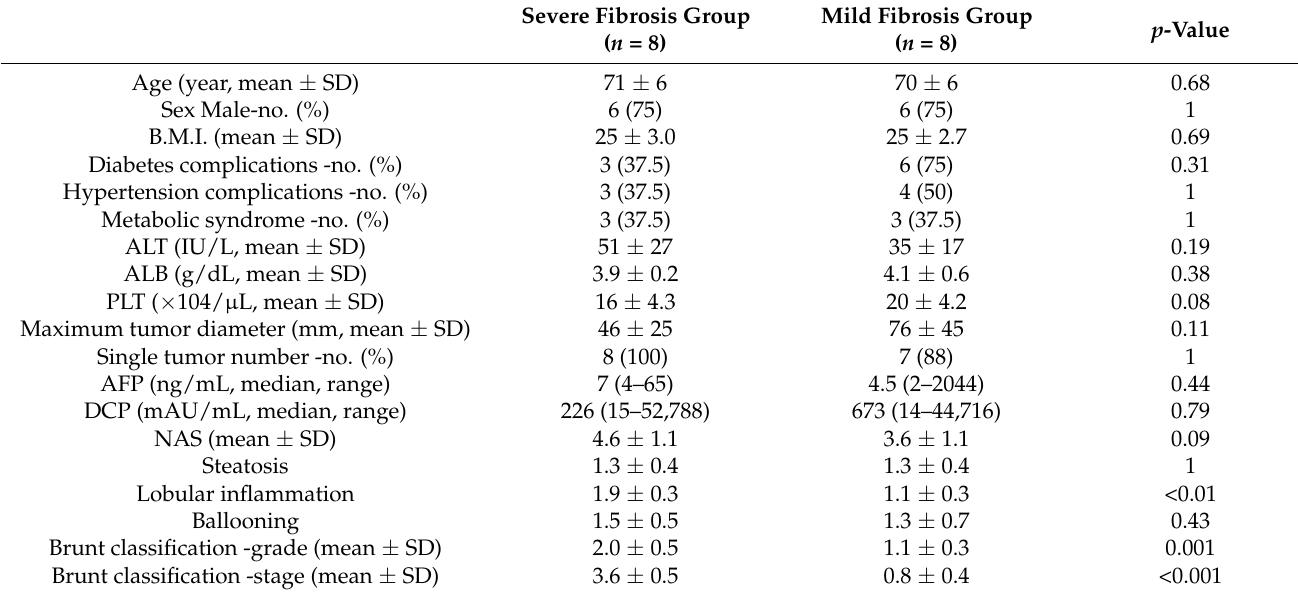
Table 1. Comparison of clinical and pathological results of patients.